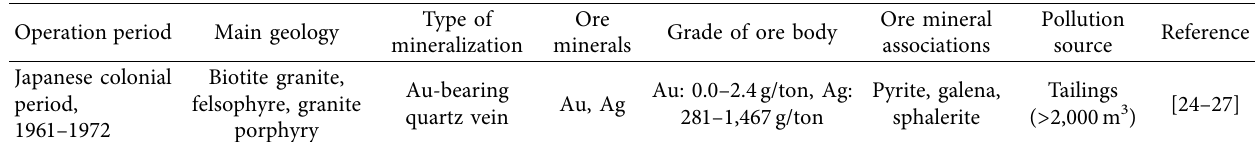
Figure 2: Geological map of the study area. Table 1: Description of the abandoned mine in the study